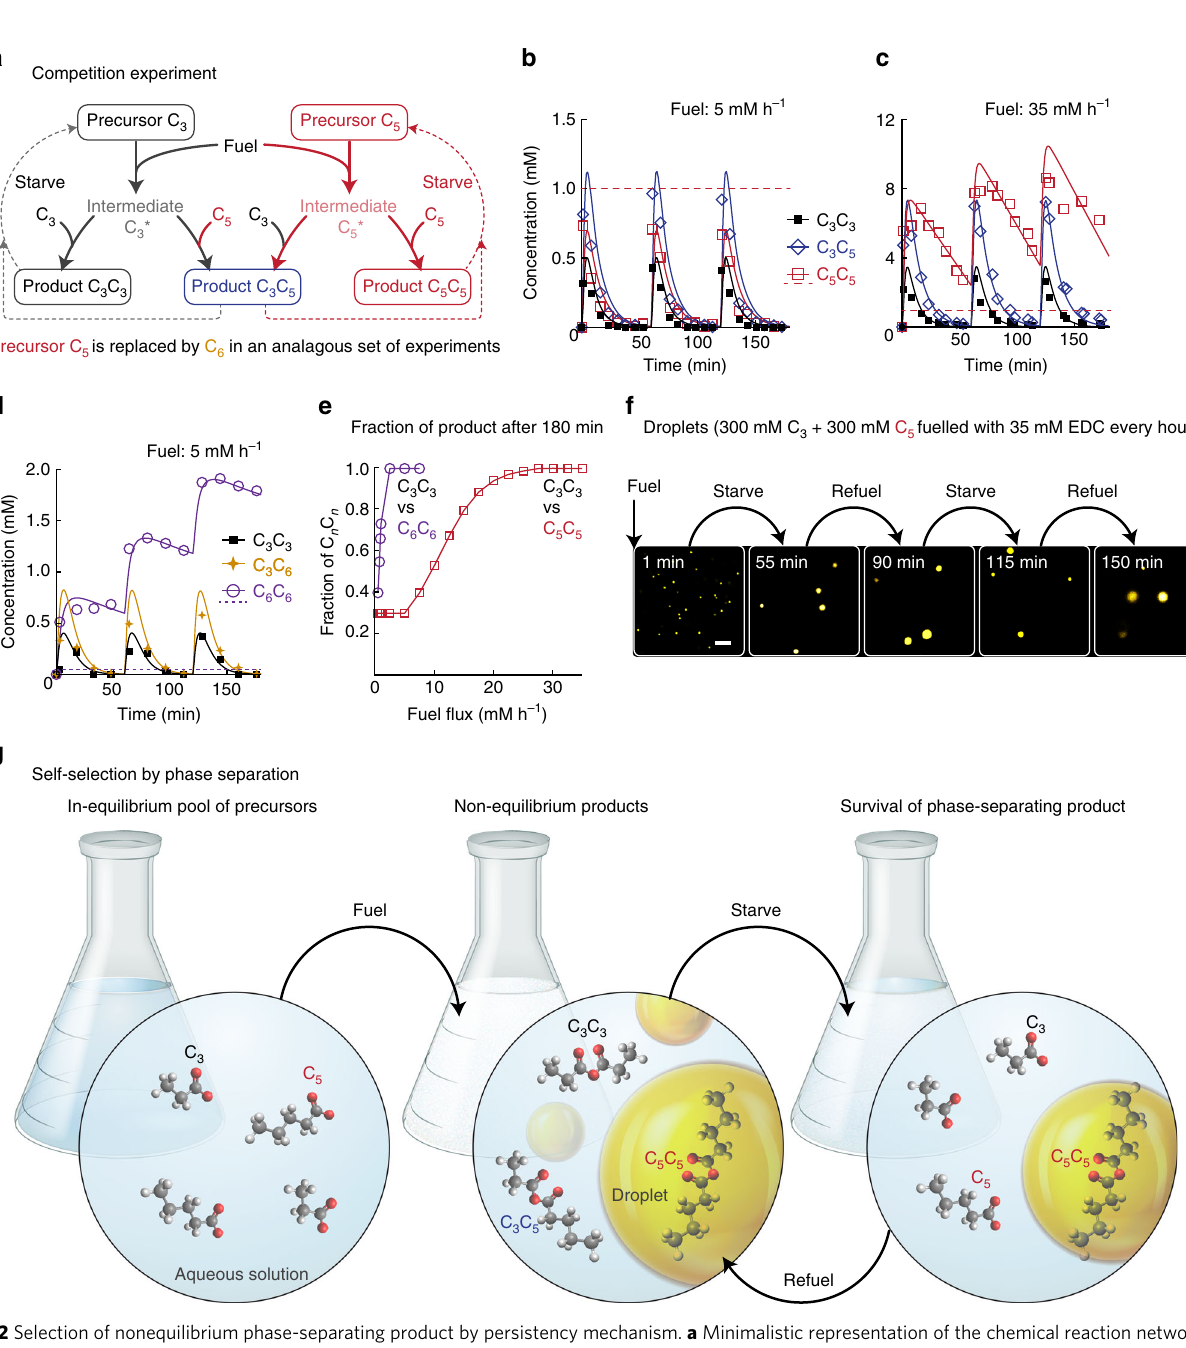
Fig. 2 Selection of nonequilibrium phase-separating product by persistency mechanism. a Minimalistic representation of the chemical reaction networks in competition experiments when C 3 and C 5 are competing. C n represents carboxylic acid precursors, C n * the activated precursors and C n C m the transient anhydride products. Three products are to be expected. Dashed arrows indicate anhydride hydrolysis reactions, whereas bold arrows depict activation reactions. The concentration of anhydride over time when 300 mM C 3 and 300 mM C 5 are fueled with 5 ( b ) or 35 ( c ) mM EDC each hour and when d 100 mM C 3 and 100 mM C 6 are fueled with 5 mM EDC each hour. Markers represent HPLC data; solid lines represent calculated data. Dashed lines represent the solubility of the C 5 C 5 (red) or C 6 C 6 (purple). e Fraction of the higher carbon number product after 3 h for C 5 C 5 (red) and C 6 C 6 (purple) against fuel fl ux. The red curve shows the competition between 300 mM C 3 and 300 mM C 5 , whereas the purple curve shows 100 mM C 3 and 100 mM C 6 . Markers represent calculated data; the connecting line is added to guide the eye. f Representative micrographs showing the evolution of the fueling-starvation- refueling experiment when 300 mM C 3 and 300 mM C 5 are fueled with 35 mM EDC every hour. Scale bars represent 5 µ m. g A library of primitive carboxylic acids (C n ) in water is fueled by high-energy condensing agents to form a mixture of nonequilibrium anhydride products (C n C m ). Products that phase-separate (e.g., C 5 C 5 ) in micro-droplets were found to be most persistent and could survive starvation periods. After multiple fueling-starvation rounds, a population of self-selected persistent nonequilibrium droplets was